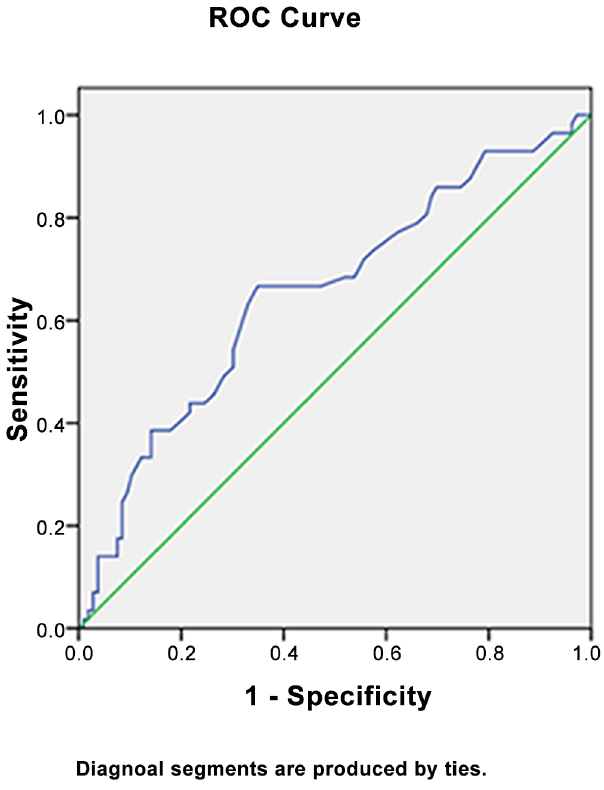
Fig 1. ROC curve for preoperative monocyte count. The ROC curve for preoperative monocyte count is represented by the line chart with an AUC of 0.653 (95% CI: 0.563~0.742, P = .001).